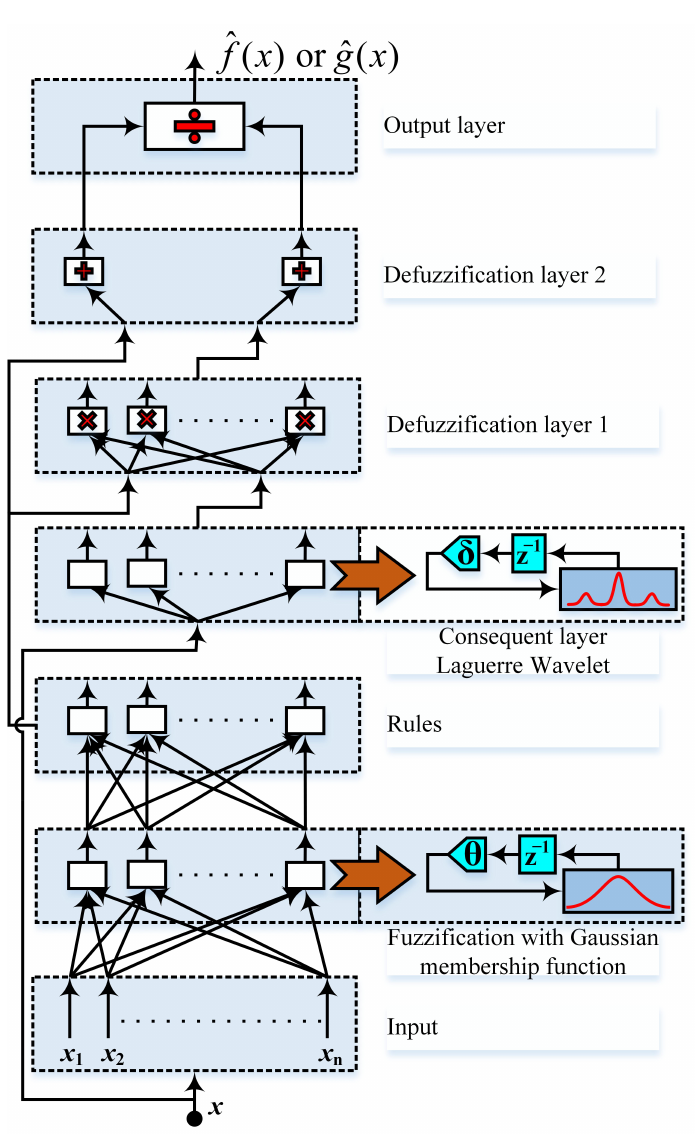
Figure 3. Architecture of the Fully Recurrent NeuroFuzzy